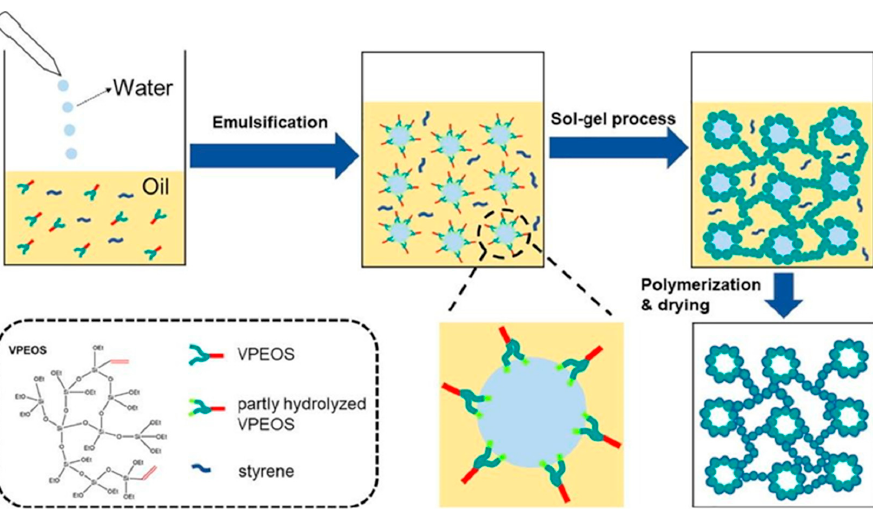
Figure 1. Polymer modification via polymerization of water-in-oil HIPE templates [17].